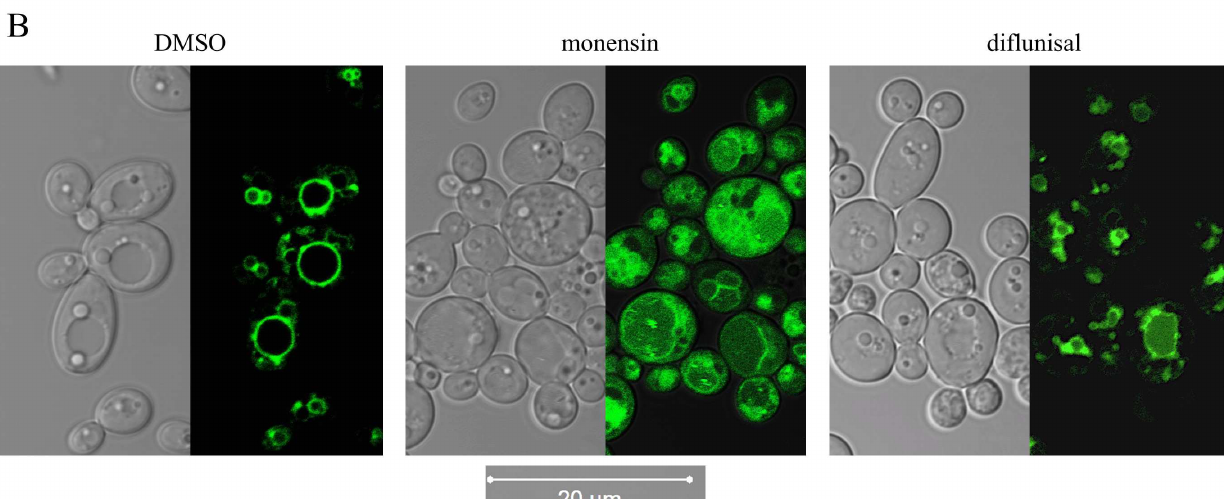
Fig 3. Several VDAs induce abnormal vacuolar morphologies. (A) Bio-imaging cellomics analysisof vacuolenumberand size and cell count. The C . albicans strain GP100, expressingcytoplasmic mCherry and vacuolarmembraneGFP- YPT72 , was exposedto each VDA at 5 and 25 μ M at 30˚C. The numbersof cells and the number and size of the vacuoleswere determinedfor each individualcell present in 16 different fields in each well, and that for 6 wells for each compound. The Spot detector BioApplication (HCS Studio ™ Cell Analysis Software) was optimizedto identify each fungal cell via the mCherry channel, and the number and size of each vacuole,within each cell, via the GFP channel. Numbersin brackets indicate the fold variationrelative to DMSO treated cells. Only significantdecreaseor increaseis shown (p-value < 0.0001).